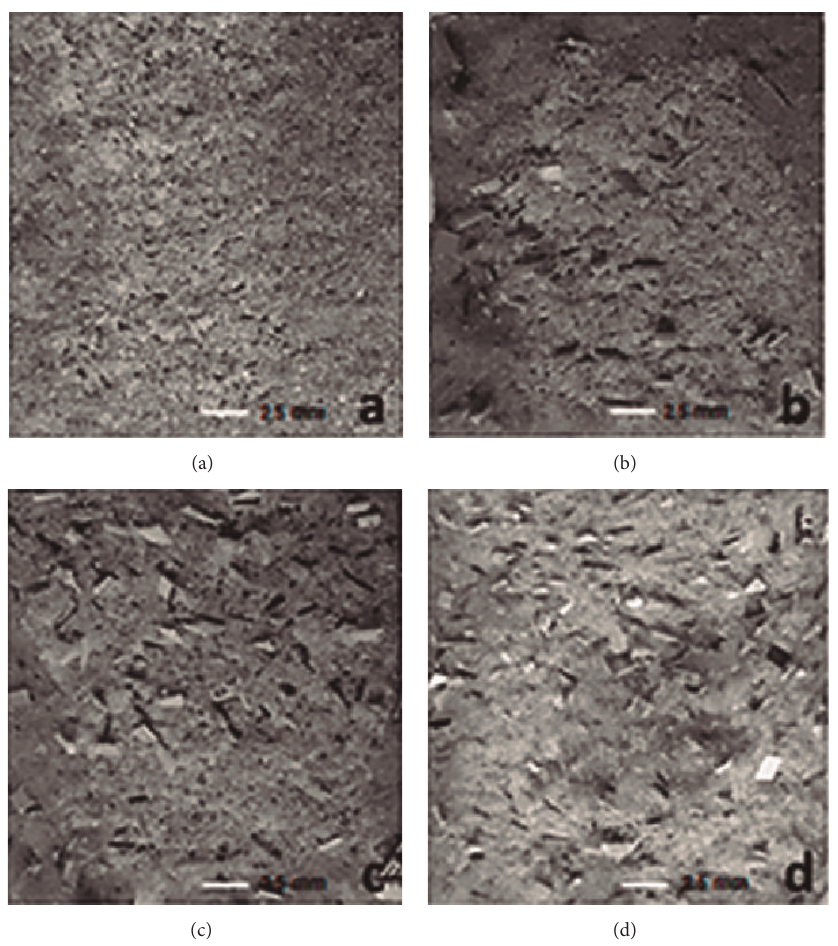
Figure 2: Polymer concrete (a) without Tetra Pak particles and with (b) 2 wt%, (c) 4wt%, and (d) 6 wt%.